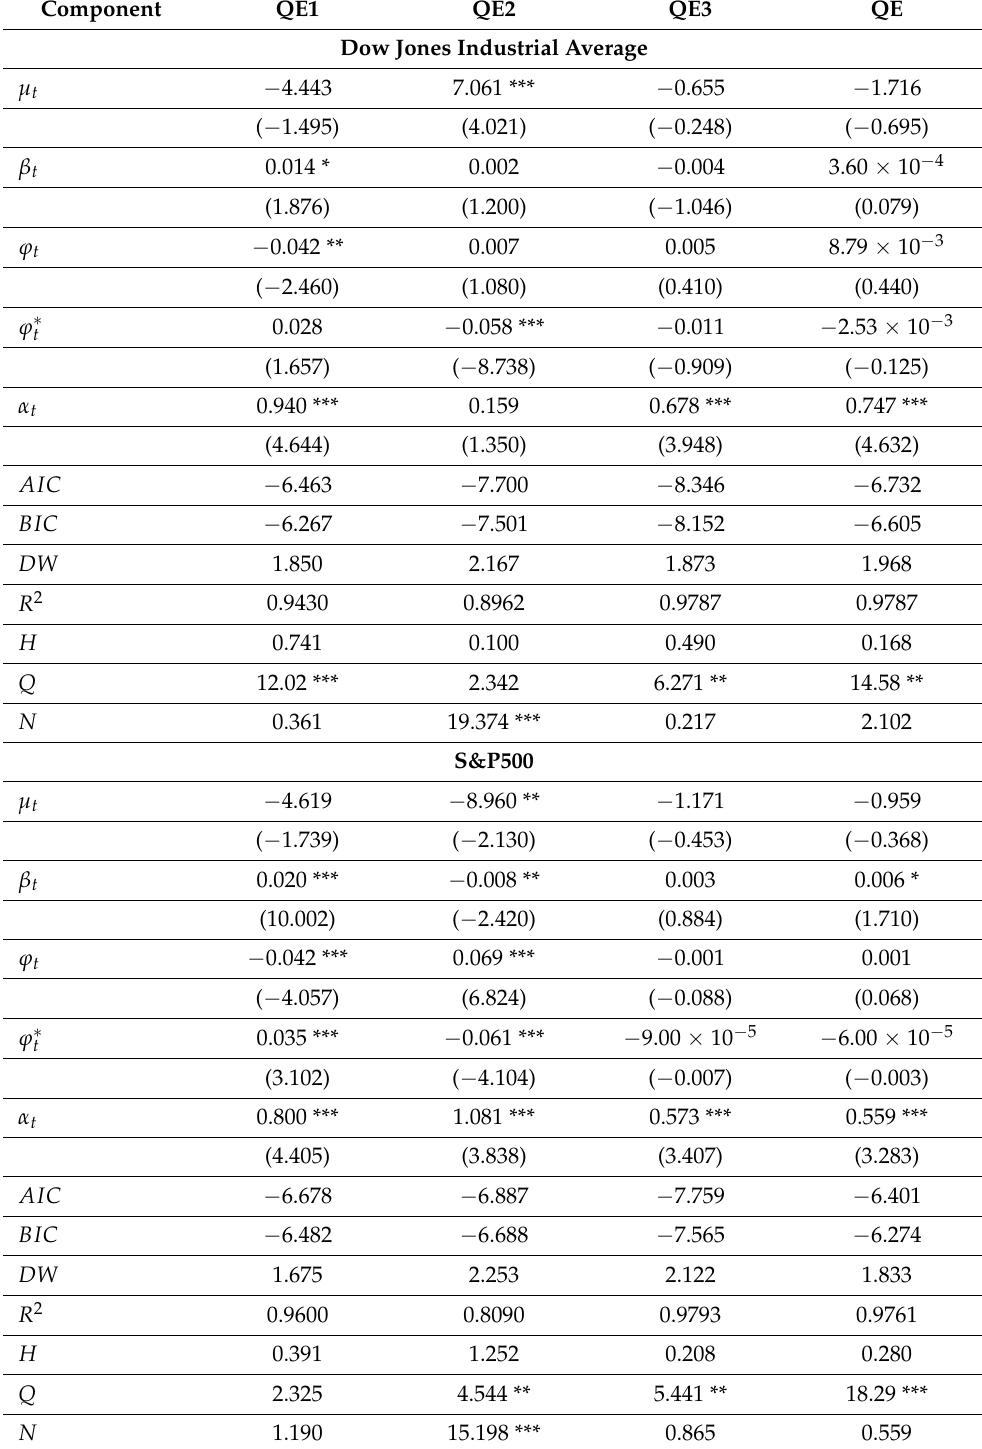
Table 2. Results of Estimating the Model for the Federal